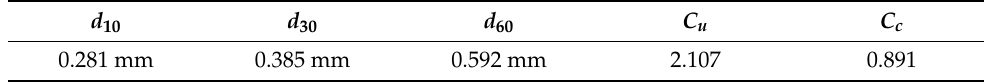
Table 1. Particle parameters of calcareous